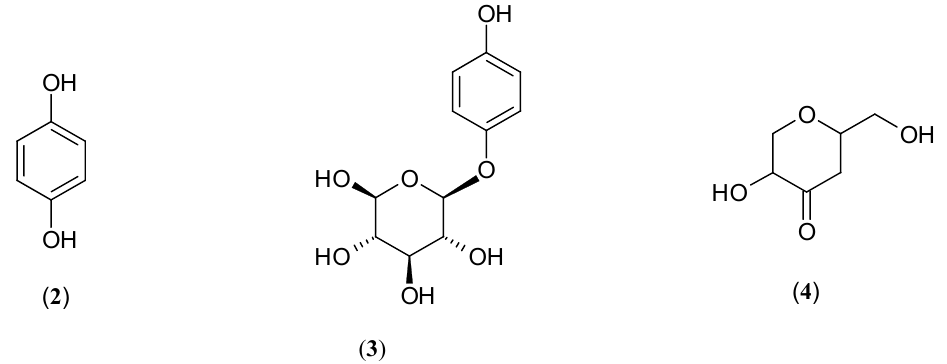
Figure 2. Structures of hydroquinone ( 2 ), arbutin ( 3 ) and kojic acid ( 4 ), frequently used as reference standards.